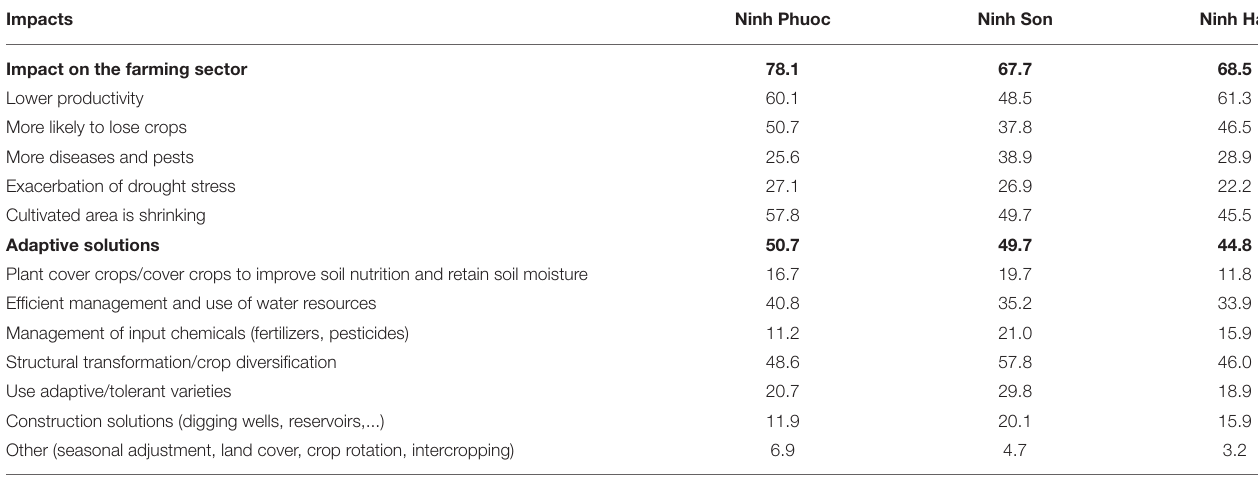
TABLE 5 | The impact of climate change crop production and adaptation measures by farmers’ perceptions (% households). Impacts